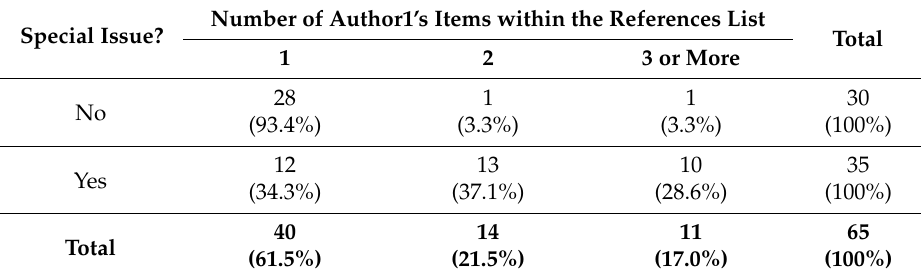
Table 4. Number of Author1 paper citations according to the journal’s issue type.